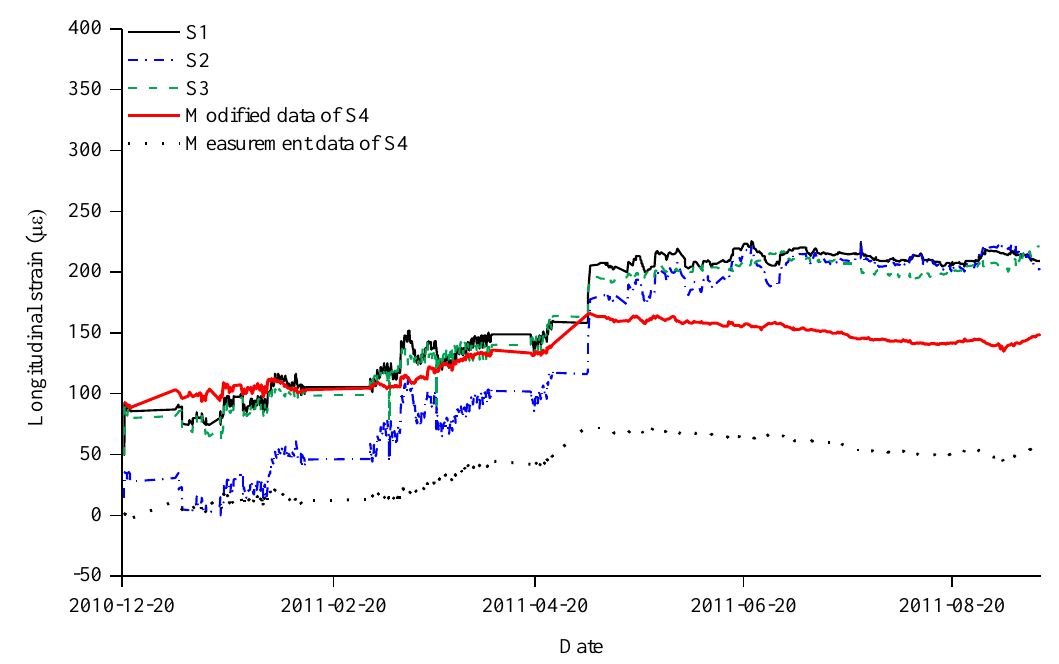
Figure 7. Measured strains from S1, S2, S3, and S4 and modified strain by adding the accumulated strain of 91.52 for S4 (Zone